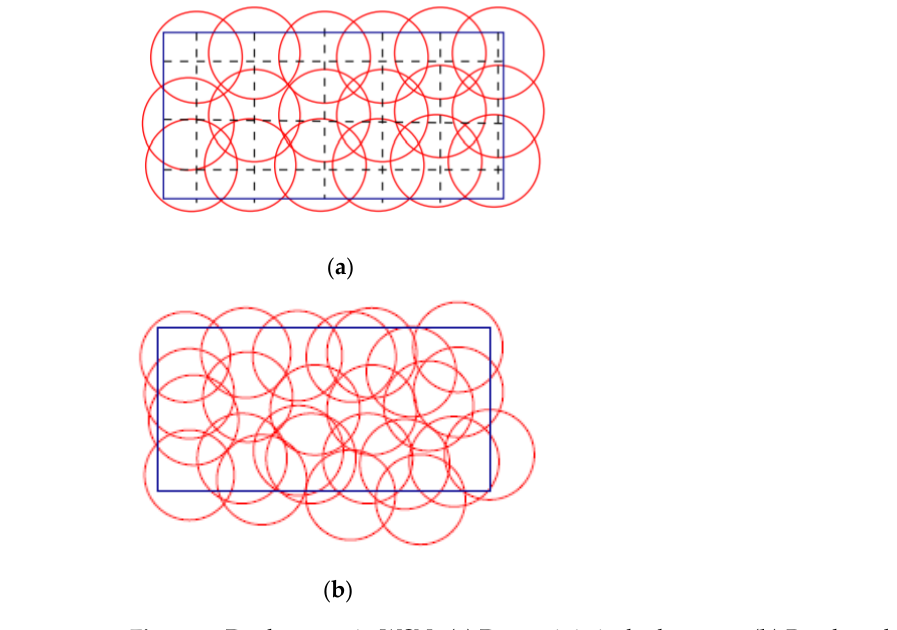
Figure 5. Deployment in WSNs ( a ) Deterministic deployment. ( b ) Random deployment [14]. Homogeneous and heterogeneous sensor nodes are two classifications of sensor node types. In homogenous WSNs, sensors are having the same characteristics with respect to sensing range, communication range, energy, and storage. Homogeneous WSNs’ cover ‐ age and connection have been examined in many of the literatures [15–19]. Nonetheless, maintaining the homogeneity in WSNs is neither possible nor practical, given certain con ‐ straints. The first concern is the cost of WSNs, since the high processing power needed for complicated activities results in a costly sensor node. The cost ‐ effectiveness of a WSN is best shown by include both expensive and cheap sensor nodes. The second challenge is how to deploy sensor nodes once the system is in operation. When it comes to WSNs, heterogeneous sensor nodes are the most important. The ranges of sensor nodes may vary to meet the needs of WSNs. While this adjustment helps lower energy use, it also intro ‐ duces heterogeneity within WSNs. Authors of [13] proposed a weight ‐ aware sensor deployment method based on each sensing grid’s weight. The sensor grid is evaluated using Seesaw mapping to reflect fac ‐ tors that include the risk of abnormalities, their consequences, and the time it takes to tolerate such incidents. In order to get an optimum balance between reliability, the exist ‐ ence of field obstacles, and the number of sensors, several weight ‐ aware sensor deploy ‐ ment algorithms are developed to address each of these criteria. However, sensor nodes have important characteristics that these algorithms do not account address. Some sensor nodes use more energy, the number of times may switch from on to off or vice versa, and the number of movements. The lifespan of sensor nodes is a critical challenge in WSN since its operation is highly dependent on such nodes. Indeed, neglecting the decrease in node lifetime caused by its movement across the various zones and its status transitioning from on to off may decrease network performance. In the context of time ‐ varying differential surveillance requirements, the authors of [6] presents a modelling framework for heterogeneous sensor deployment. It first formu ‐ lates the problem as an optimization problem using a mixed ‐ integer mathematical pro ‐ gramming to maximize field coverage. This is accomplished by using two meta ‐ heuristics. The first heuristic solution uses a Genetic Method (GA), while the second heuristic solu ‐ tion utilizes a Simulated Annealing (SA) algorithm. This framework was created to sup ‐ port large ‐ scale surveillance operations, including integrating multiple sets of heteroge ‐ neous sensors into a single deployment strategy. The sensors’ main characteristics such as energy, allowed number of state ‐ switching, allowed number of moves, and reliability are considered. Meanwhile, the analysis of the proposed framework in [6] shows that the movement distance and movement consumed energy are not considered. This might have a negative influence on network performance, as described above. A two Flower Pollination Algorithms (FPA) are proposed in [20] to solve the hetero ‐ geneous node deployment optimization problem in WSNs with obstacles in the monitor ‐ ing area. Due to the shortcomings of FPA, such as the low convergence speed and the